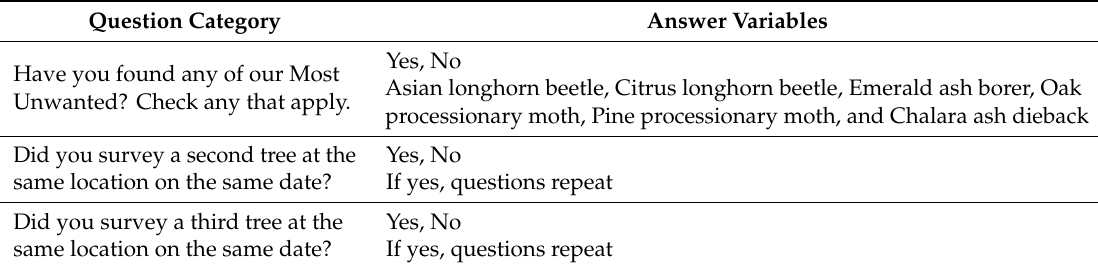
Table 5. Summarised recorded variables for Activity 3, “Most